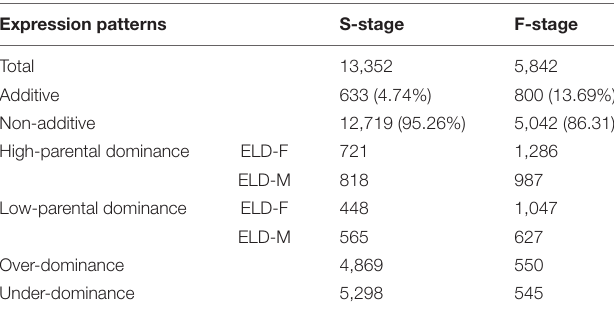
TABLE 1 | Differentially expressed genes between the hybrid and its parents at the seedling and flowering stages.